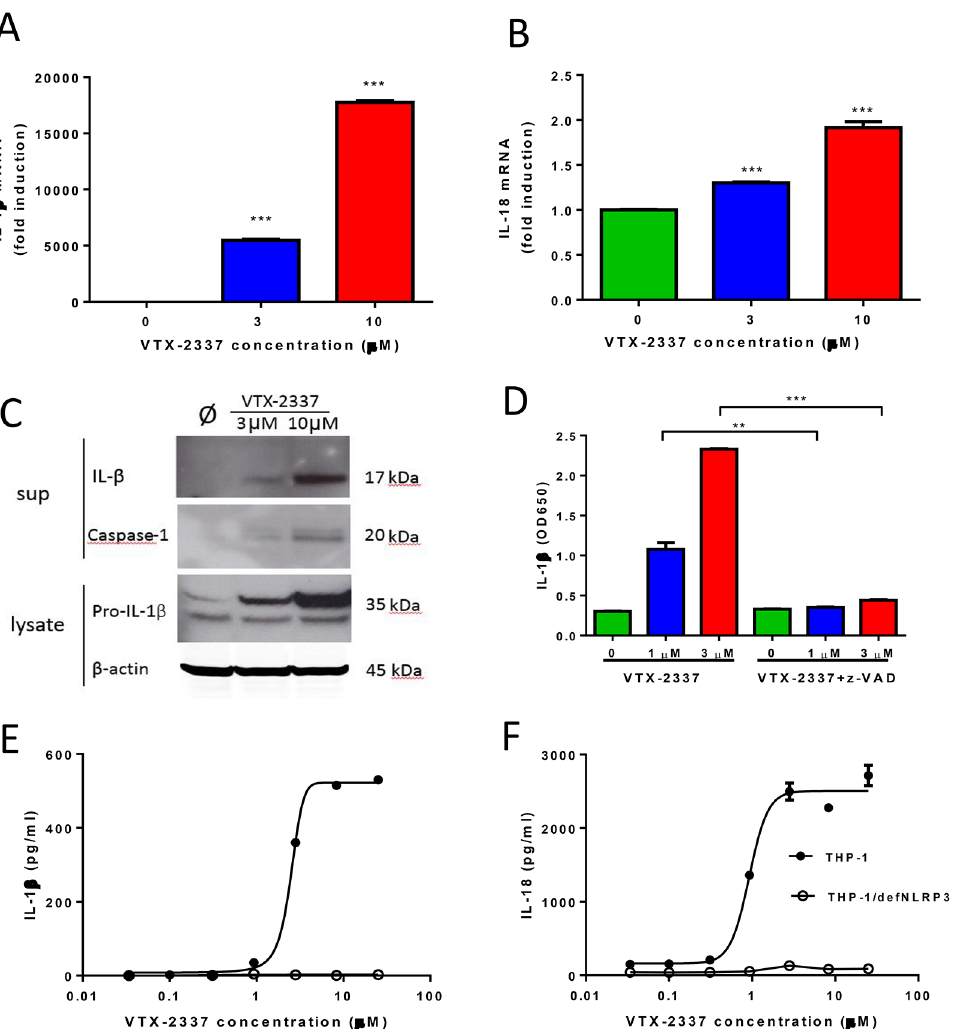
Fig 2. VTX-2337 induces mature IL-1 β and IL-18 via NLRP3 inflammasome activation in THP-1 cells. (A-B) VTX-2337 induced pro-IL-1 β and pro-IL-18 mRNA expression in THP-1 cells. Cells were cultured overnight in medium or VTX-2337 (3 or 10 μ M), and expression of IL-1 β and IL-18 mRNA, normalized to β -actin levels, were measured by real-time RT-PCR. (C) Western blot analysis of IL-1 β and caspase-1 protein levels in THP-1 culture supernatants, and pro-IL-1 β protein levels in cell lysates, following overnight activation with medium ( Ø ), or VTX-2337 (3 or 10 μ M). (D) Pretreatment with caspase-1 inhibitor z- VAD blocks VTX-2337-induced secretion of mature IL-1 β . Triplicate THP-1 cultures (10 μ g/ml) were treated with VTX-2337. Levels of IL-1 β in the presence or absence of z-VAD-FMK were assessed using HEK-Blue ™ IL-1 β cells (mean ± sem). (E and F) Levels of secreted IL-1 β and IL-18 following overnight VTX- 2337 stimulation (0.03 to 25 μ M in 1:3 serial dilutions) in wild type THP-1 ( ● ) and NLRP3 deficient THP-1 (THP-1/NLRP3 def ) cells ( (cid:1) ). Levels of IL-1 β and IL- 18 (mean ± sem) in culture supernatant from triplicate wells were measured by ELISA. All results shown are representative of three independent experiments. ** , p < 0.01, *** , p < 0.001 by unpaired Student